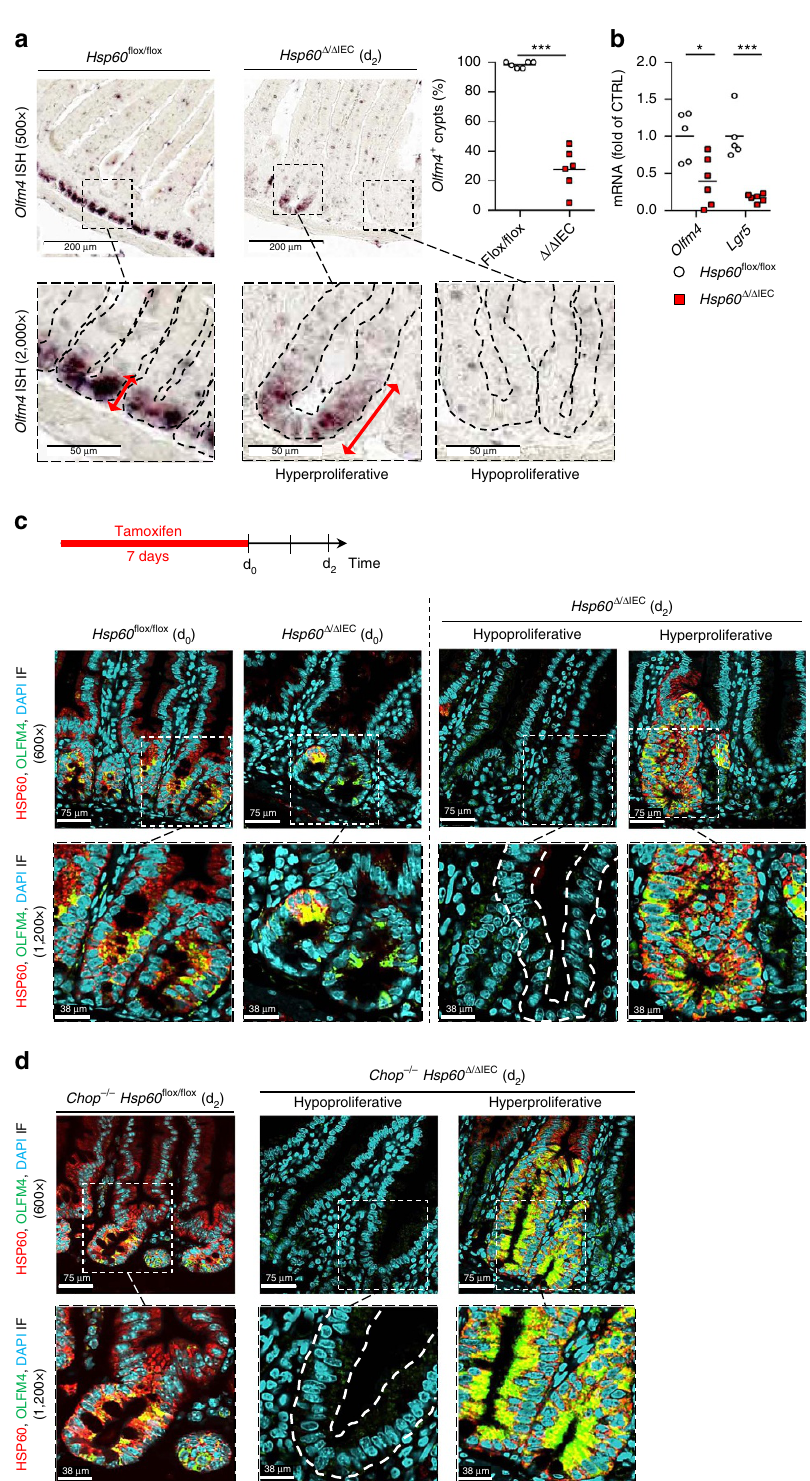
Figure 5 | HSP60 loss antagonizes stemness while HSP60-positive escaper stem cells hyperproliferate. ( a ) Images showing representative in situ hybridizations for Olfm4 mRNA on jejunal sections at d 2 including detailed images in higher magnification and quantification of Olfm4 -positive crypts ( N ¼ 6); dotted lines indicate localization of cryptal epithelium; red arrows indicate zones of Olfm4 expression). The dot plot indicates number of Olfm4 þ crypts in Hsp60 flox/flox and Hsp60 D / D IEC mice at d 2 . ( b ) qRT–PCR analysis of stem cell markers Olfm4 and Lgr5 was performed on isolated crypt bottom IEC of Hsp60 flox/flox ( N ¼ 5) versus Hsp60 D / D IEC mice ( N ¼ 6). Lines in the dot plots indicate mean numbers. All statistical analyses were performed via unpaired t -tests comparing genotypes. ( c ) Schedule for oral tamoxifen administration to induce HSP60 deficiency in IEC. IF images show HSP60 and OLFM4 expression at two different time points (d 0 and d 2 ) in jejunal sections of Hsp60 D / D IEC and Hsp60 flox/flox mice (DAPI stains nuclei in cyan). Representative pictures of N ¼ 5 per genotype. ( d ) Parallel analysis as in c for Chop (cid:2) / (cid:2) Hsp60 D / D IEC mice and corresponding Chop (cid:2) / (cid:2) Hsp60 flox/flox controls. Asterisks indicate significant differences * P o 0.05, ** P o 0.01, *** P o 0.001; NS, not